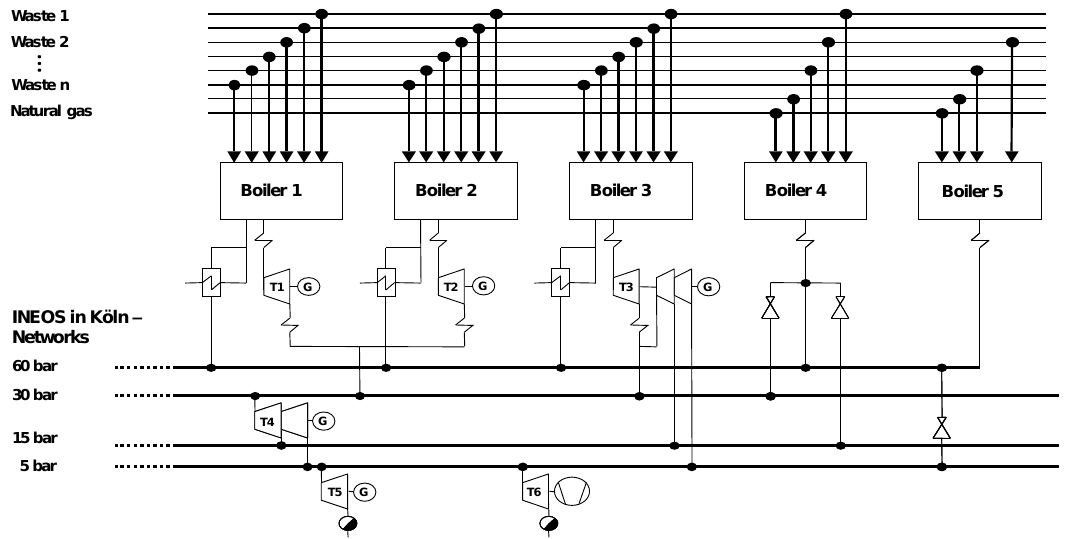
Figure 1. The schematic of the power plant of INEOS in Köln. Table 1. The minimum stay time constraints [h] of operation modes of Boilers (B) and Turbines (T).